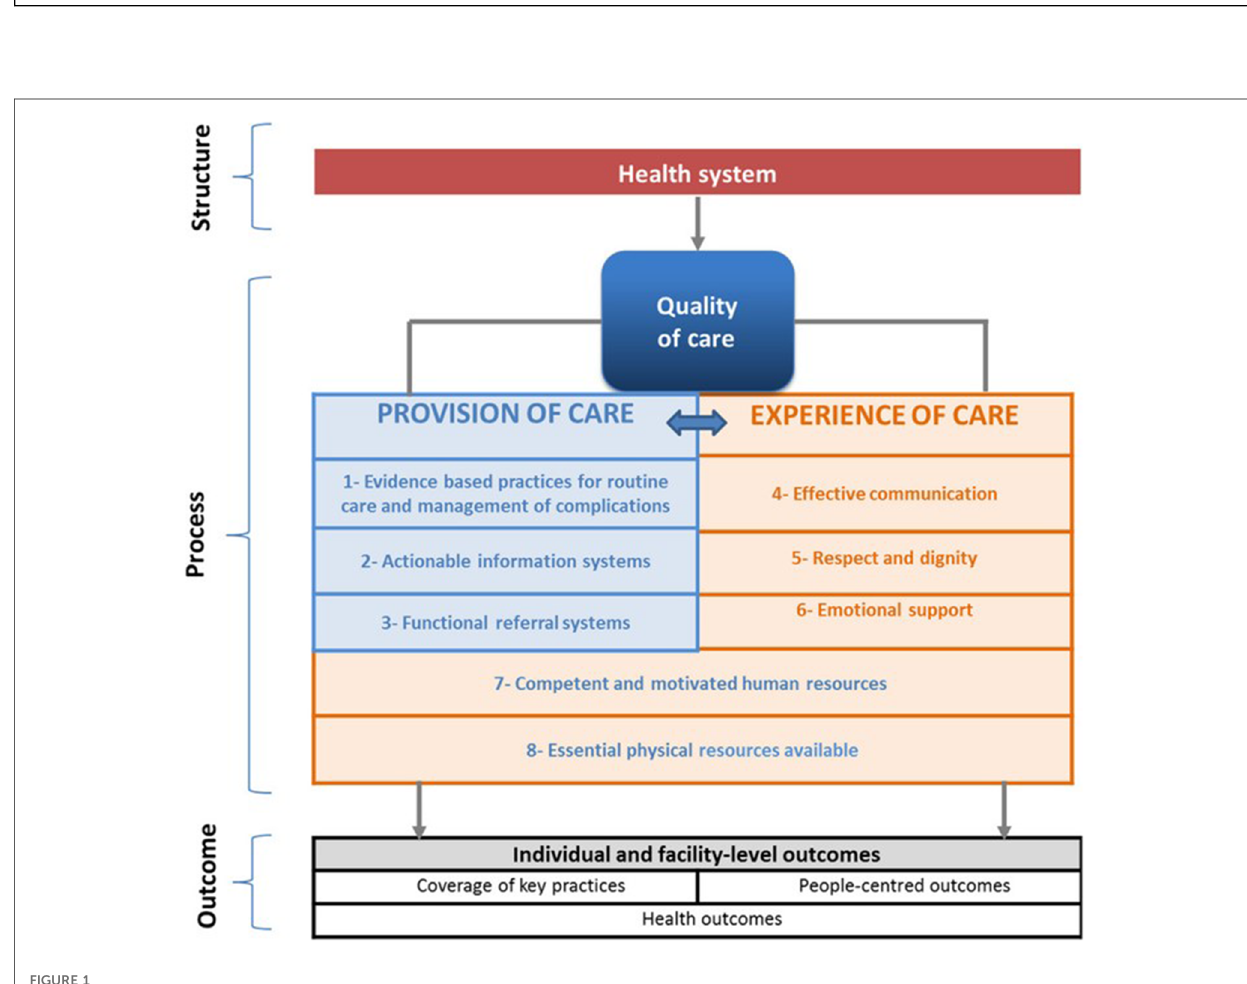
FIGURE 1 Reprinted from Tunçalp et al. 2015 (4) with